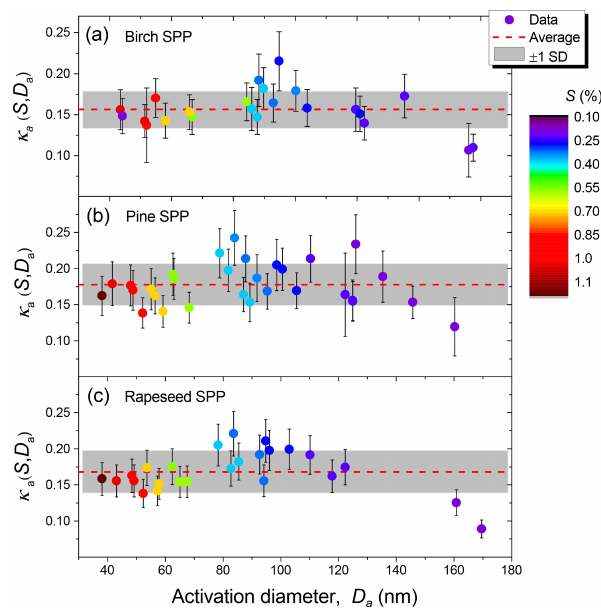
Figure 8. Shape-corrected hygroscopicity, κ a , as a function of aerosol particles activation diameter, D a , and supersaturation, S (color code), of birch (a) , pine (b) , and rapeseed (c) subpollen par- ticles. The red line and gray shaded area correspond to average κ a ± SD.